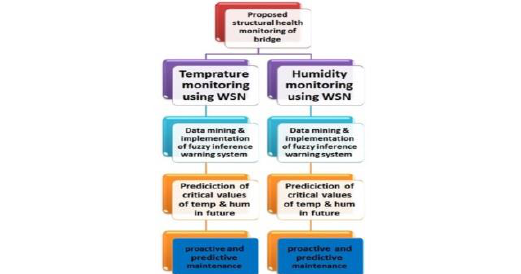
Figure 3. layout of PCB of board and bias circuits of temperature and humidity sensors.